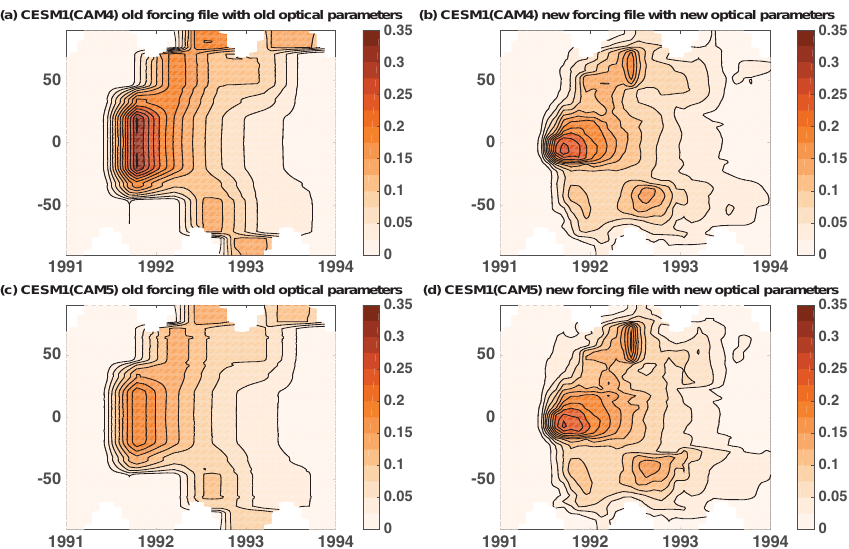
Figure 3. Monthly times series comparison of the zonal mean SAOD at 550nm after the 1991 Mt. Pinatubo eruption for the old (a, c) and new (b, d) prescribed stratospheric aerosol schemes in CESM1(CAM4) (a, b) and CESM1(CAM5) (c, d) . Results for CESM1(WACCM4) and CESM1(CAM4-Chem) are not shown as the new stratospheric aerosols are identical to those utilized in the new CESM1(CAM4) prescription.